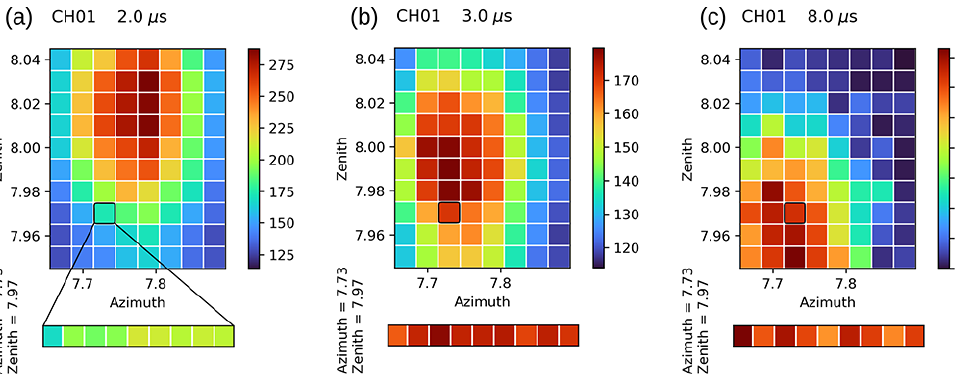
Figure 17. Laser mapping signal (CH01 analogue signal before normalization with the reference position signal) at three different ranges expressed as delays at the top of the bin ( a : 2.0µs – 300m; b : 3.0µs – 450m; c : 8.0µs – 1200m). The reference position (Az = 7.73, Zen = 7 . 97) is highlighted by the black square. Measurements in this position are acquired every zenith acquisition sequence and are represented in the lower array.